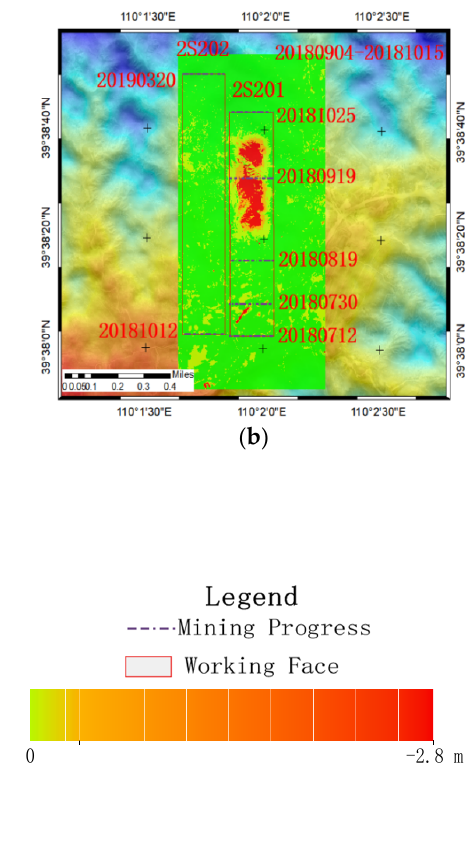
Figure 7. Example of fusion methods. ( a ) Interpolation and superposition subsidence map by SBA- SInSAR, DInSAR and UAV; ( b ) subsidence map by the fusion method; The date marked in red is